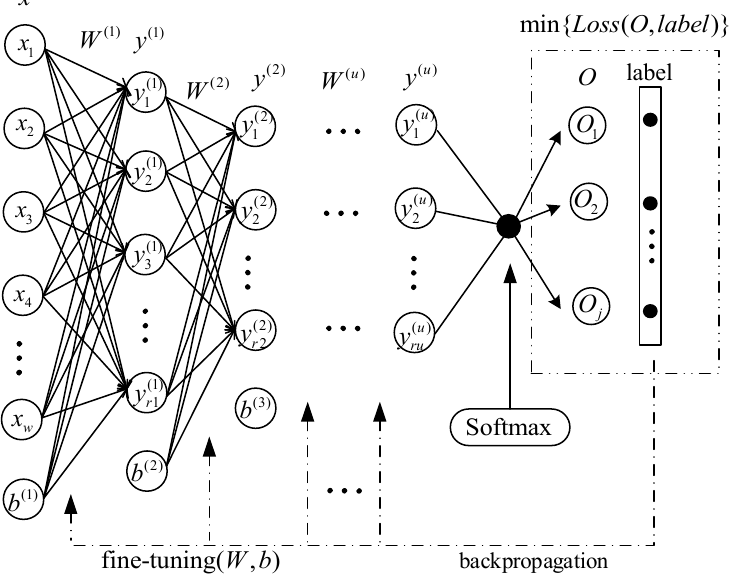
Figure 4. S-SAE network fine-tuning process.